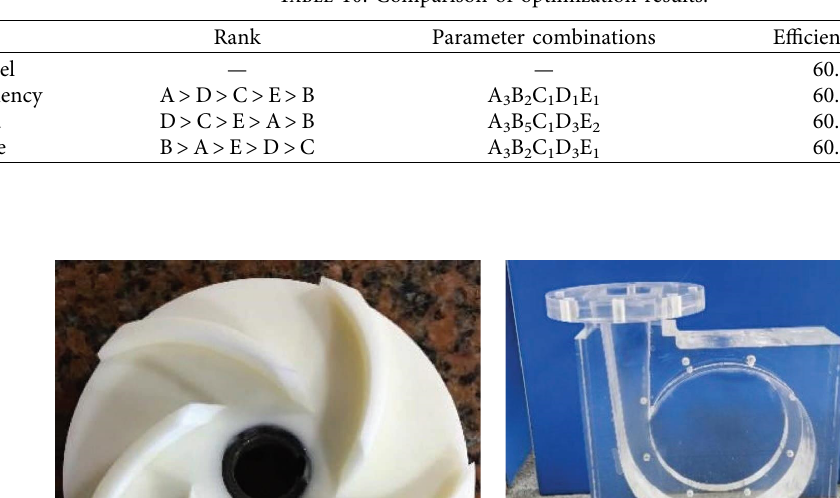
Table 10: Comparison of optimization results.